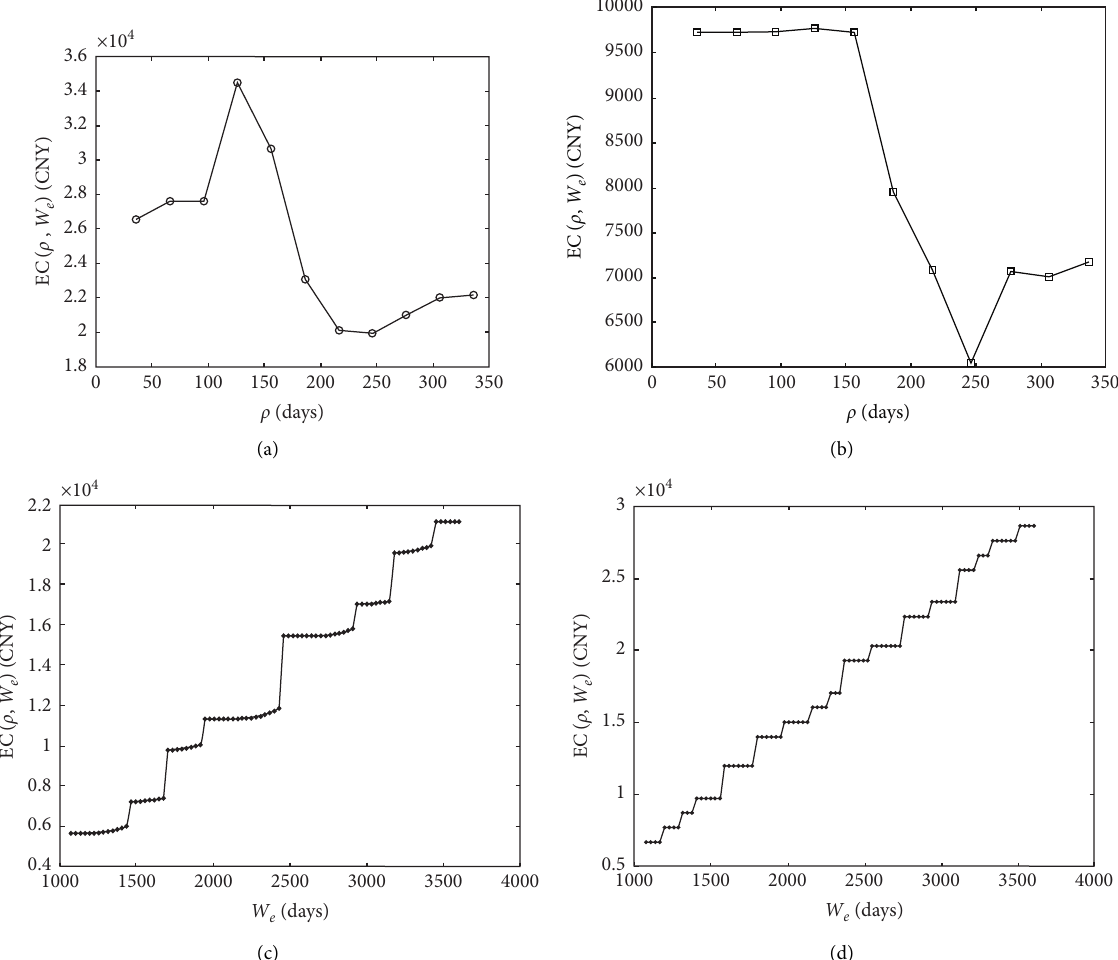
Figure 10: The dimensionality reduction analysis chart of the system EW cost. (a) W (d) ρ � 96